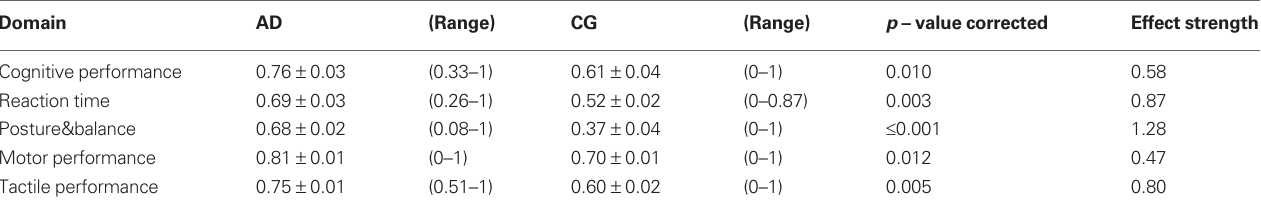
Table 2 | indices of performance (iP) averaged across individual tasks describing cognition, reaction times, posture&balance, and motor and tactile performance for both groups.